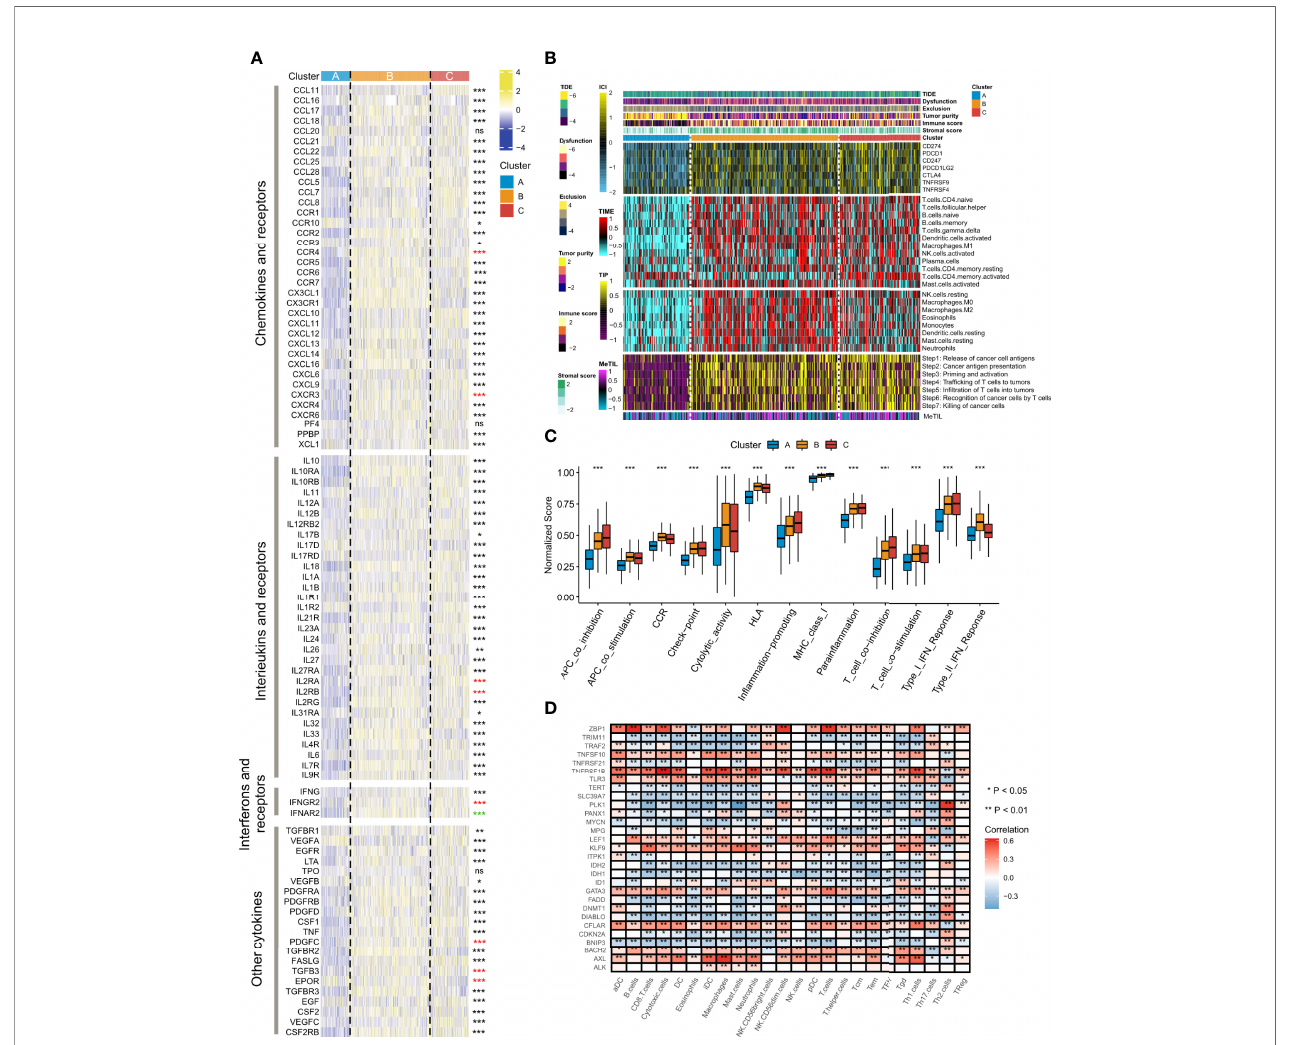
FIGURE 3 | Alterations of immunomodulators and several quanti fi ed types of tumor immune microenvironment among the three necroptosis phenotypes. (A) The heatmap showed changes of mRNA expression levels of chemokines, interleukins, alterons and their corresponding receptors, and other cytokines among the three necroptosis subtypes. Asterisks represented p-value (***p < 0.001, **p < 0.01, *p < 0.05, and ns was the abbreviation of no signi fi cance), the color of which represented methods of statistical tests. Black denoted Kruskal-Wallis test, red denoted one-way ANOVA test, and green denoted Welch one-way ANOVA test. (B) The composite heatmap showed the tumor immune microenvironment pro fi le in the TCGA-LUAD cohort, with the top panel showing the variations of several immune checkpoints, the middle panel showing enrichment scores of 24 immune cell types, and the relative bottom panel showing the enrichment levels of seven steps in the anti-tumor immune cycle. The DNA methylation level of tuWmor-in fi ltrating lymphocyte (MeTIL) was stuck in the lowest part. The TIDE score, dysfunction score, exclusion score, tumor purity, immune score, and stromal score were annotated at the top of the heatmap. (C) The variations of normalized scores of 13 immune pathways were revealed by Kruskal-Wallis test. (D) The heatmap showed the associations between the 29 necroptosis regulatory molecules and immunocytes. Red indicated positive correlations, and blue indicated negative correlations. Asterisks denoted p-value (**p < 0.01, *p < 0.05). Blank cells represented no statistical signi fi cance of the